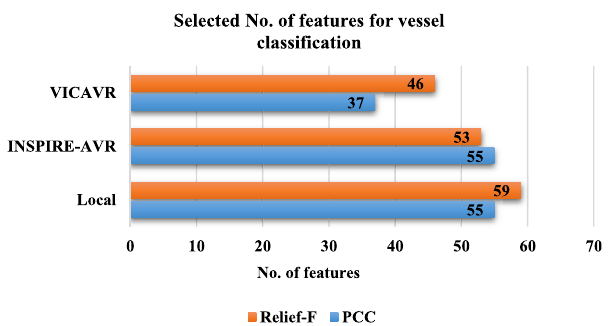
Fig. 18. Feature subsets selected for vessel classi¯cation, using two di®erent ranking methods for VICAVR, INSPIRE-AVR and Local